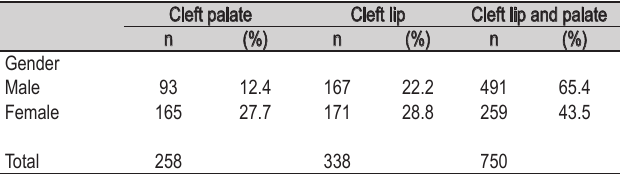
Table 1 - Distribution of non-syndromic cleft lip and/or palate according to type and gender.